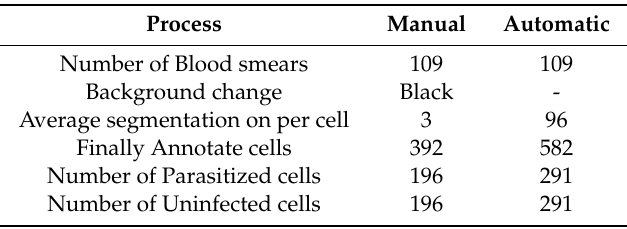
Table A1. Segmentation Table.